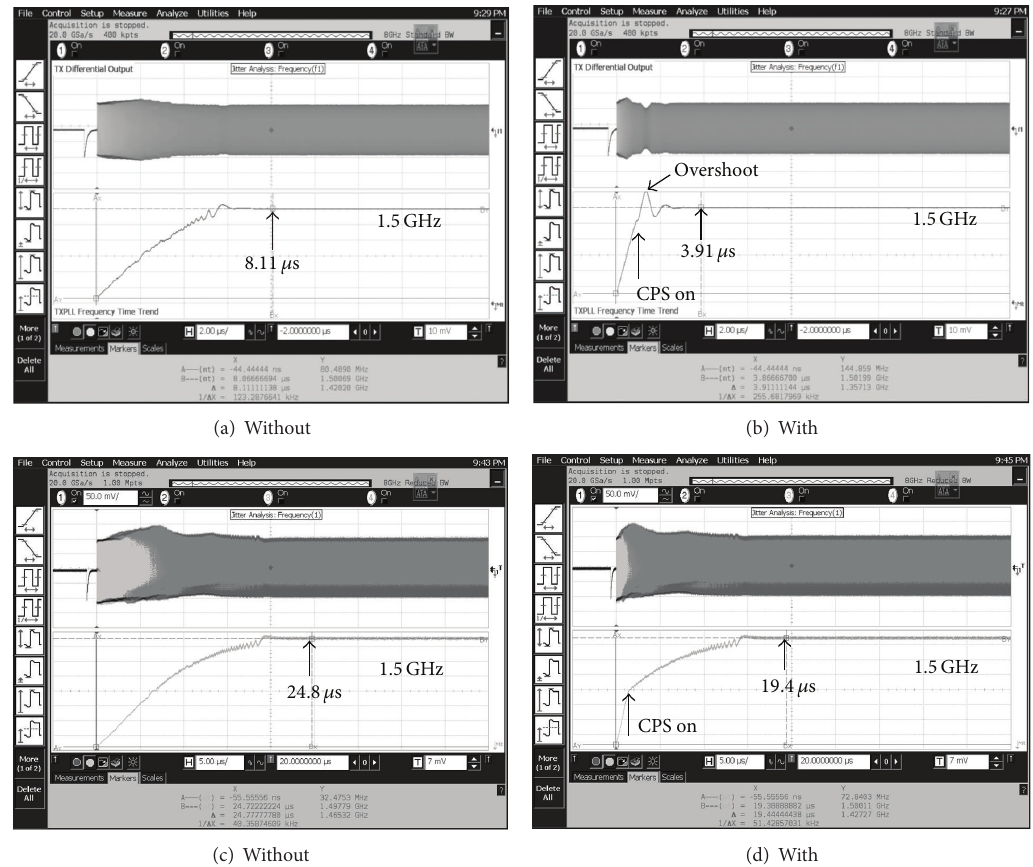
Figure 19: Measurement result of the proposed SSCG settling-period. The sample is SS. Measurement condition is 1.35 V/125 ∘ C. Without proposed fast-lock dual-CP function (a), settling-period could be less than 8.11ms. With function (b), settling-period could be less than 3.91 𝜇 s. (c) and (d) are same PLL parameter as Figure 9. Without function (c), measurement and simulation settling period are 24.8 𝜇 s and 22.5 𝜇 s, respectively. With function (d), measurement and simulation settling period are 19.4 𝜇 s and 18.2 𝜇 s, respectively.